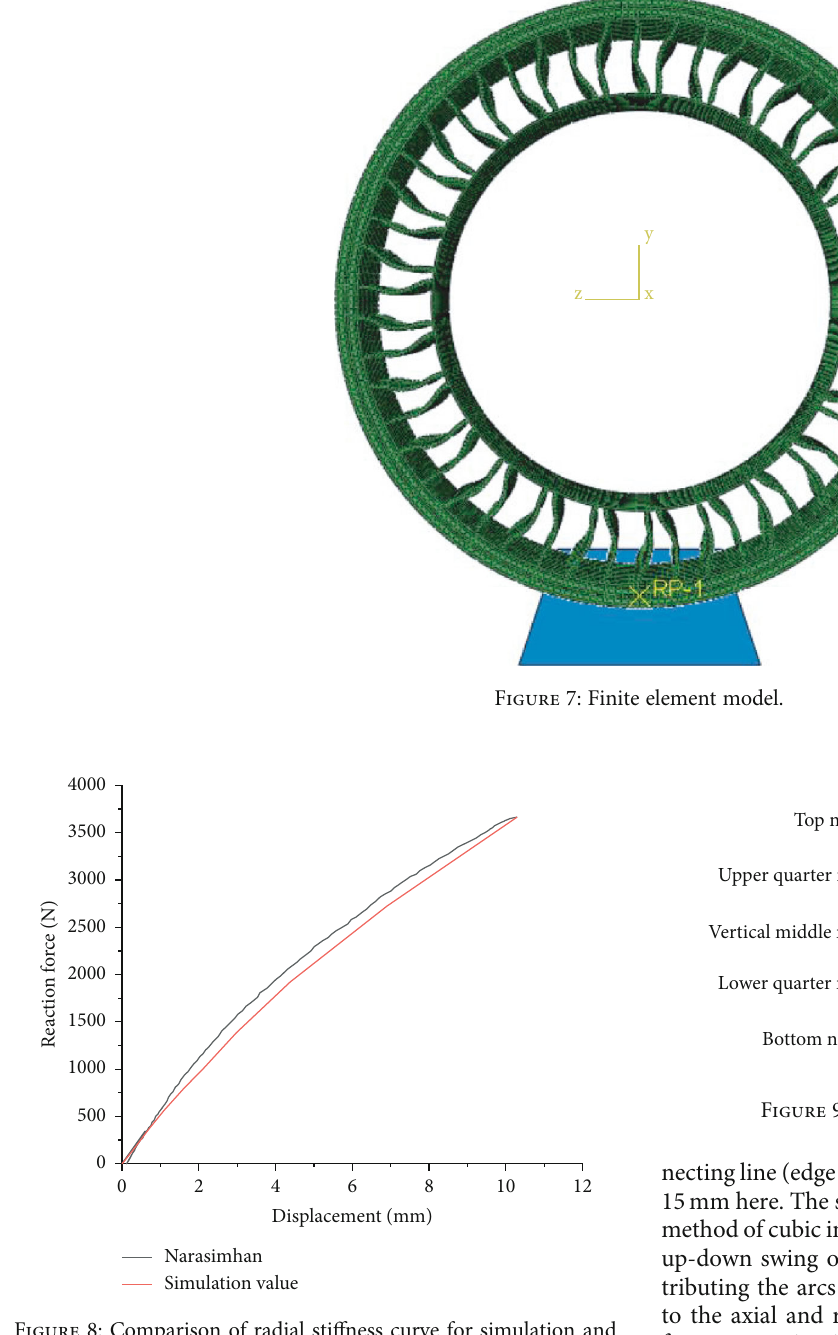
Figure 8: Comparison of radial sti ff ness curve for simulation and Narasimhan analysis value.